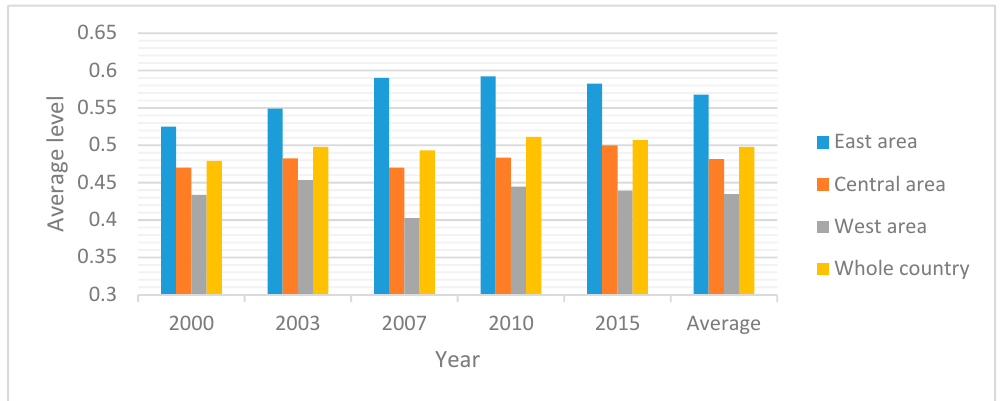
Figure 3. Average low-carbon economy level of China and its three areas.